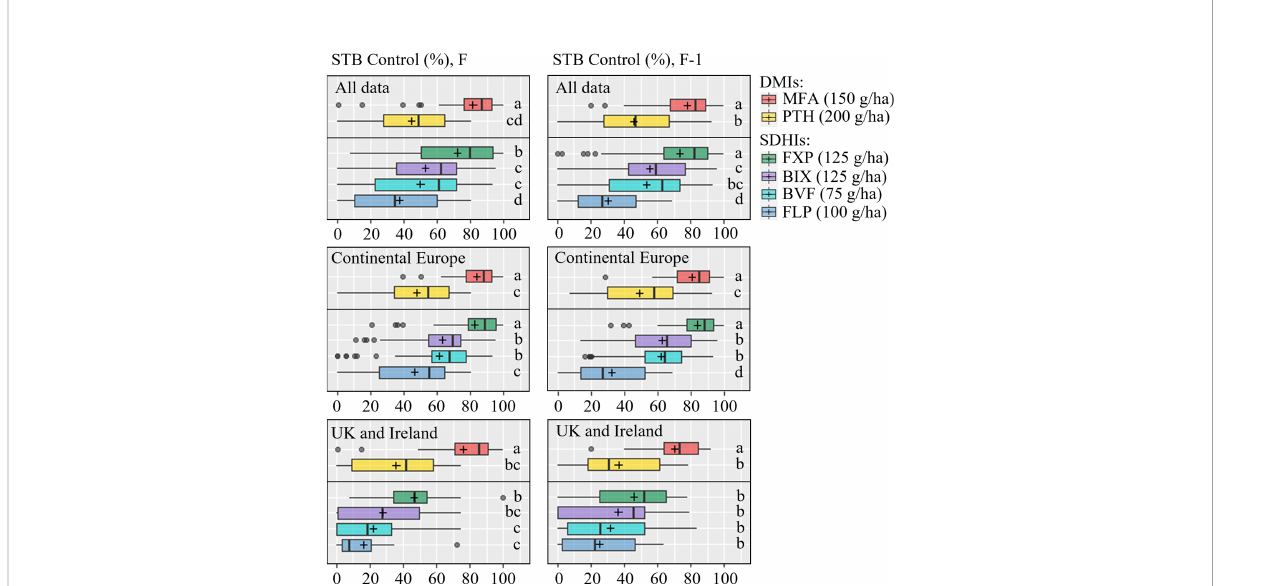
FIGURE 3 Septoria tritici blotch (STB) control (%) on fl ag leaves (left) and F-1 (right) were assessed at growth stage 65-85, 22-58 days after application in 18 trials on fl ag leaf and 19 on F-1 from 2019-2021. Trials from Continental Europe were carried out in Denmark, France, Germany, Poland and Belgium. Tested fungicides included mefentri fl uconazole (MFA), prothioconazole (PTH), fl uxapyroxad (FXP), bixafen (BIX), benzovindi fl upyr (BVF), fl uopyram (FLP). FLP was not included in 2021. The line inside the boxes indicates the median and ‘ + ’ indicates the average. Different letters represent signi fi cant differences between treatments within boxplot as determined by Dunn ’ s